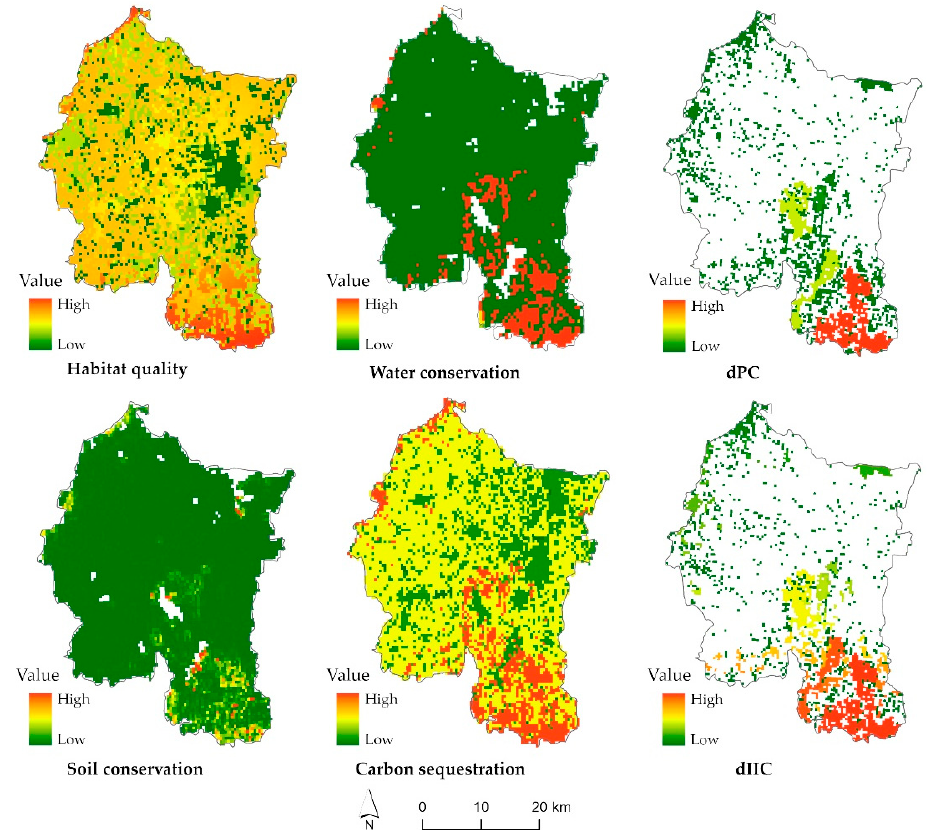
Figure 6. Evaluation of ecosystem services and connectivity importance of patches.